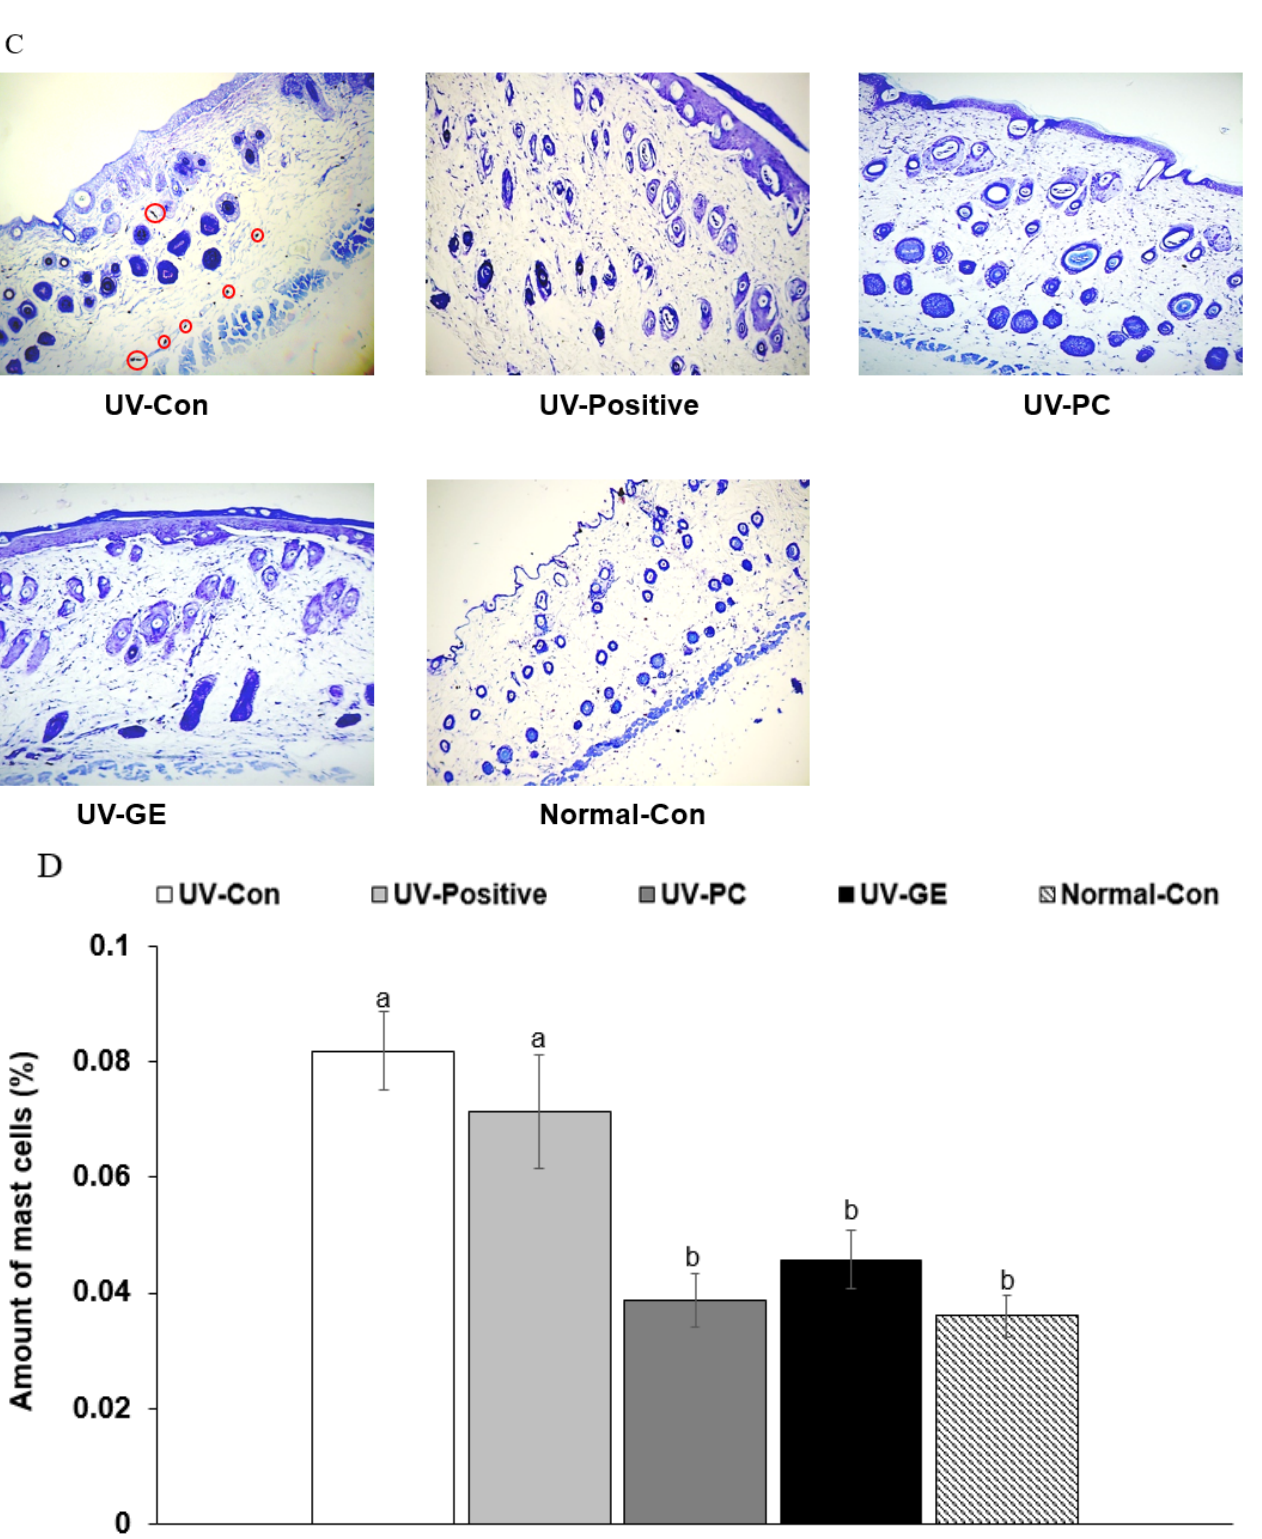
Figure 2. Histological differences and the number of mast cells in the dorsal skin. After the 21-day treatment, the dorsal skin was fixed with 10% formaldehyde, embedded in paraffin, and sections were made. The skin sections were stained with hematoxylin-eosin and toluidine blue staining. The magnification of the image was 100×. ( A ) Histology of the dorsal skin by hematoxylin-eosin staining. ( B ) The thickness of the epidermis and dermis are indicated by black lines (unit: μ m). ( C ) Mast cell staining by toluidine blue. ( D ) The number of mast cells is presented as black dots marked by red